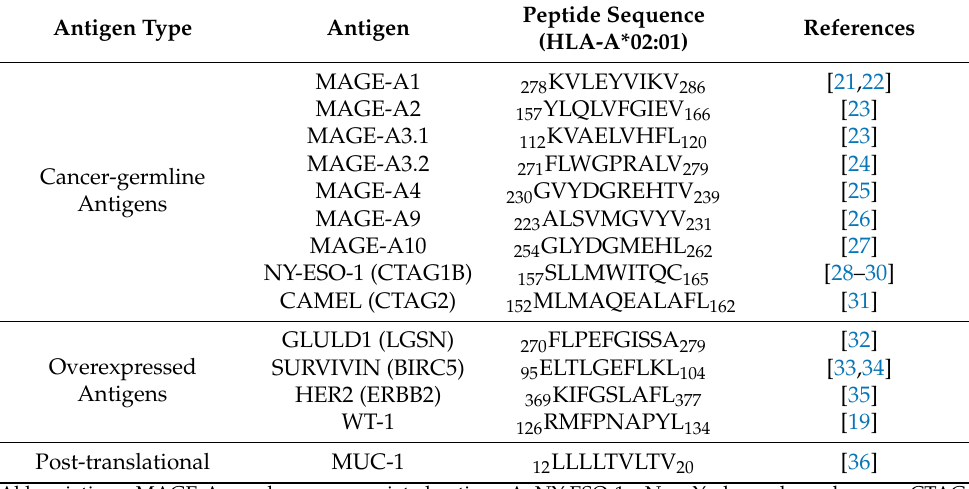
Table 1. List of the selected lung tumor antigens.